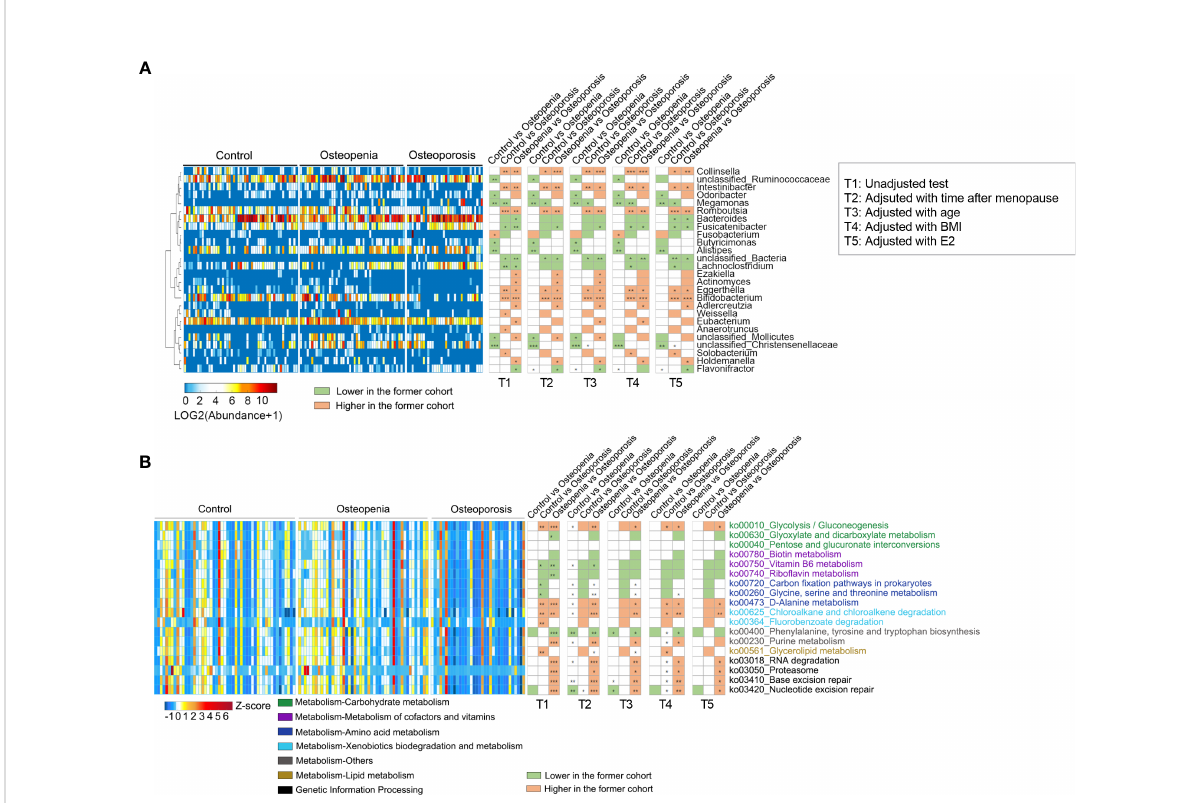
FIGURE 2 Different genera and KEGG pathways of GM among the control, osteopenia, and osteoporosis groups. (A) Different genera in the GM. The cluster of genera based on Spearman correlation coef fi cients is shown on the left. The heatmap in the middle shows the relative abundance (log2 transformed) of each genus in individual samples. Comparisons of the genera are shown in the right columns of the heatmap. All the genera were tested using the Wilcoxon rank-sum test and adjusted to FDRs.*, ** and *** represent FDR < 0.05, < 0.01 and < 0.01, respectively. (B) Differential predicted KEGG pathways. The heatmap in the middle shows the relative abundance (Z-score) of pathways in individual samples. All the pathways were tested using Wilcoxon rank-sum test and adjusted to FDRs. *, ** and *** represent FDR < 0.05, < 0.01 and < 0.01,